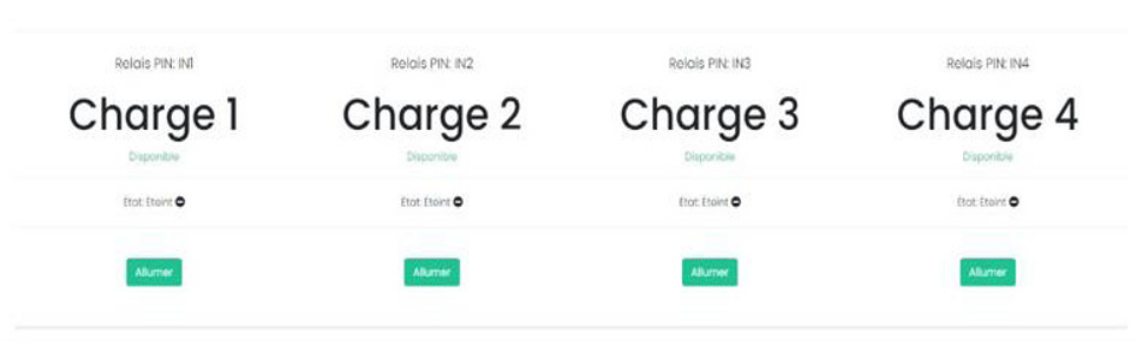
Fig. 5 Loads interface